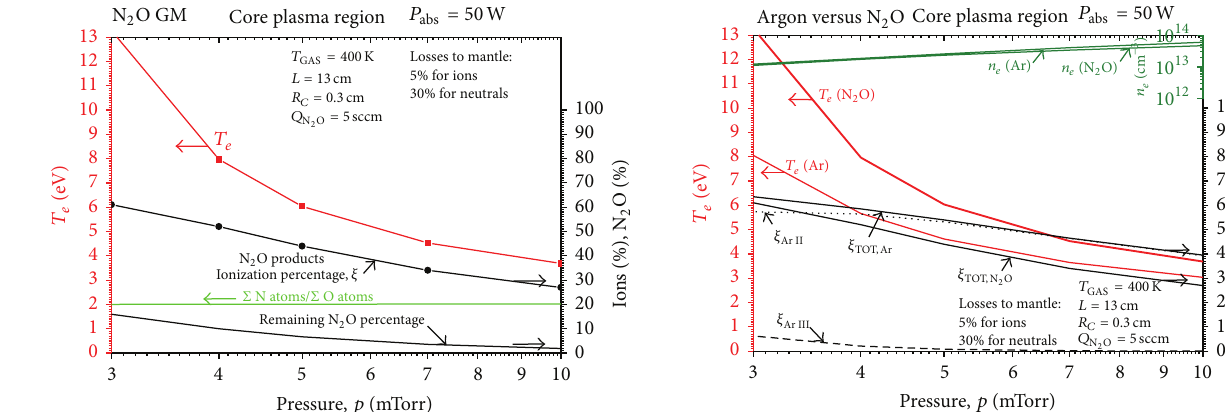
L=13 cm Q N 2 O =5 sccm